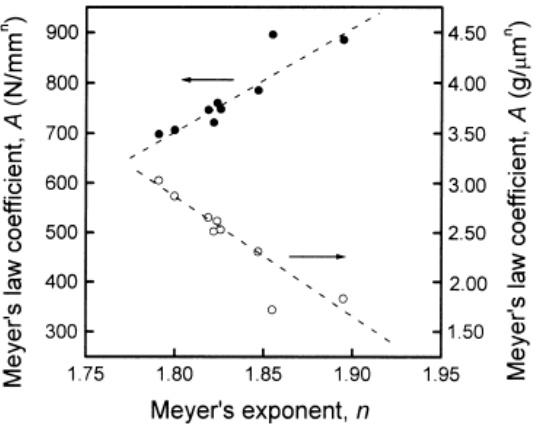
Figure 26. Variation of Meyer’s law coefficient C with Meyer’s exponent n . Note that completely different trends are observed when different unit systems were used for recording the experimental data [92].